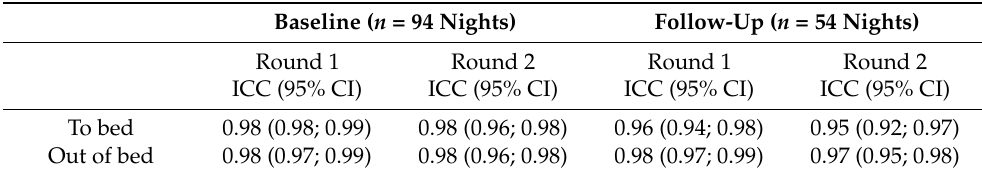
Table 3. Intraclass correlation coefficients between ZM and the average of the manual annotations between the three